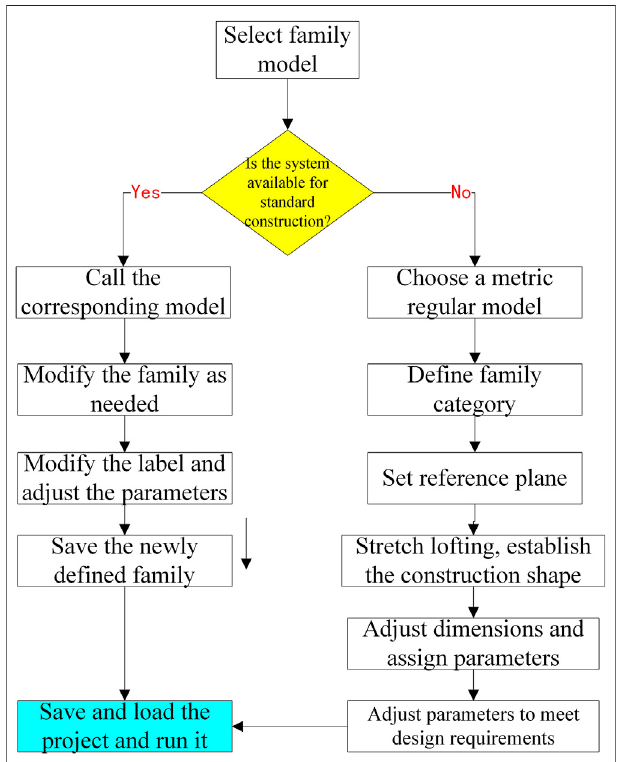
FIGURE 2 | The creation process of the Revit family fi